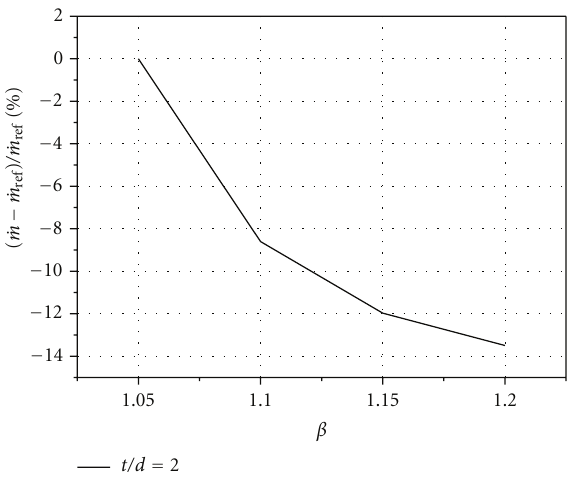
Figure 15: Total coolant mass flow rate varying the β parameter.